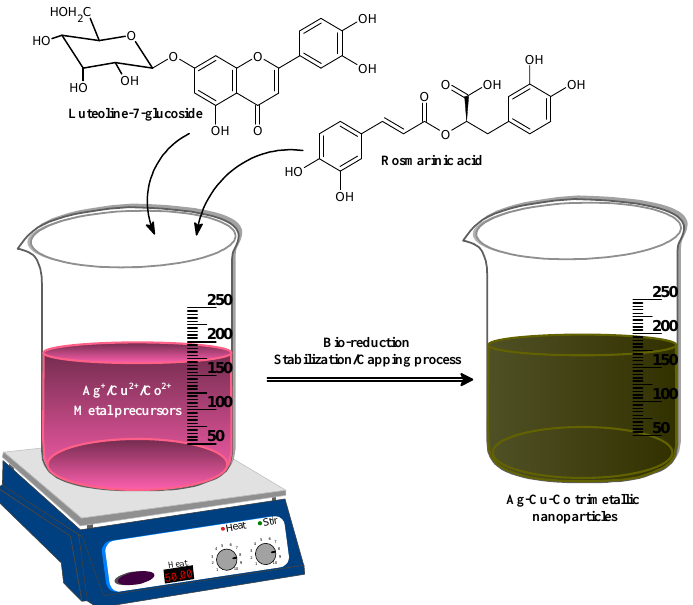
Figure 1. The Bio-fabrication mechanism of Salvia officinalis assisted Ag-Cu-Co trimetallic nanoparticles. The Salvia officinalis derived Ag-Cu-Co trimetallic nanoparticles were characterized for the possible role of bioactive molecules present in the aqueous extract, especially the engaged functional groups responsible for bio-reduction stabilization/capping of the nanoparticles. The FTIR spectrum of Salvia officinalis shows strong peaks at 3425 cm − 2